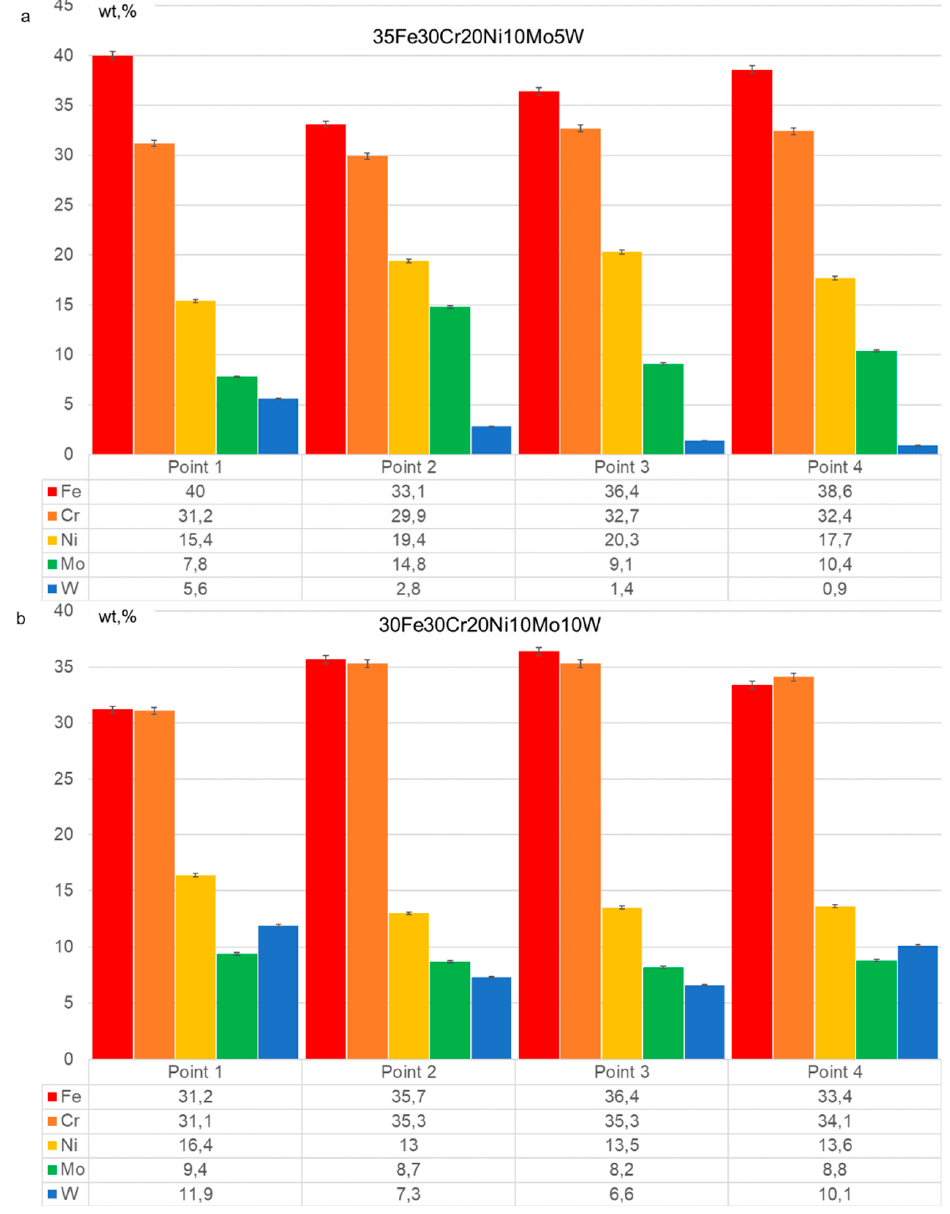
Figure 5. Elemental composition on the agglomerates’ surface according to EDS analysis: ( a )—